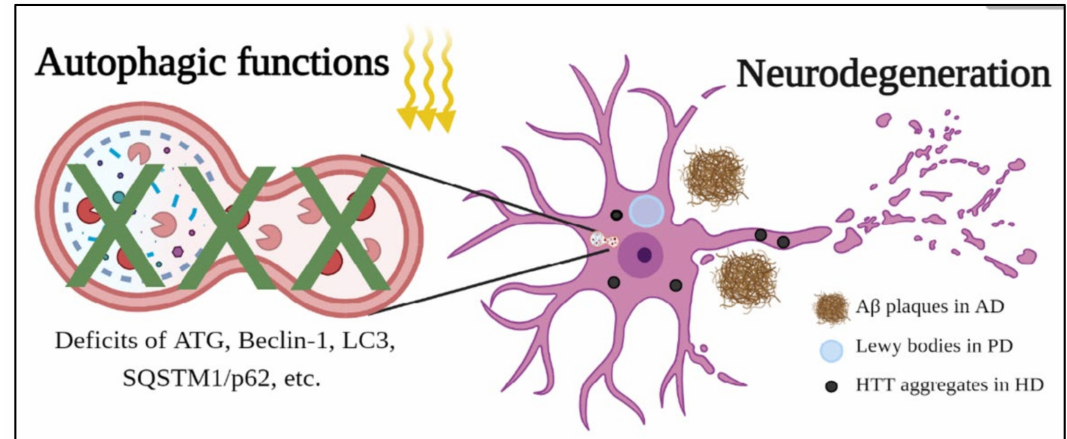
Figure 3. The role of autophagy in neurodegenerative diseases. The dysfunctions of autophagy are observed in neurode- generative diseases, including AD, PD and HD, due to deficits of ATG family, Beclin-1, LC3, SQSTM1/p62, etc. Since the autophagy could not degrade disease-causing proteins properly, accumulations of A β plaques, Lewy bodies and HTT aggregates are detected in AD, PD and HD, respectively, finally leading to